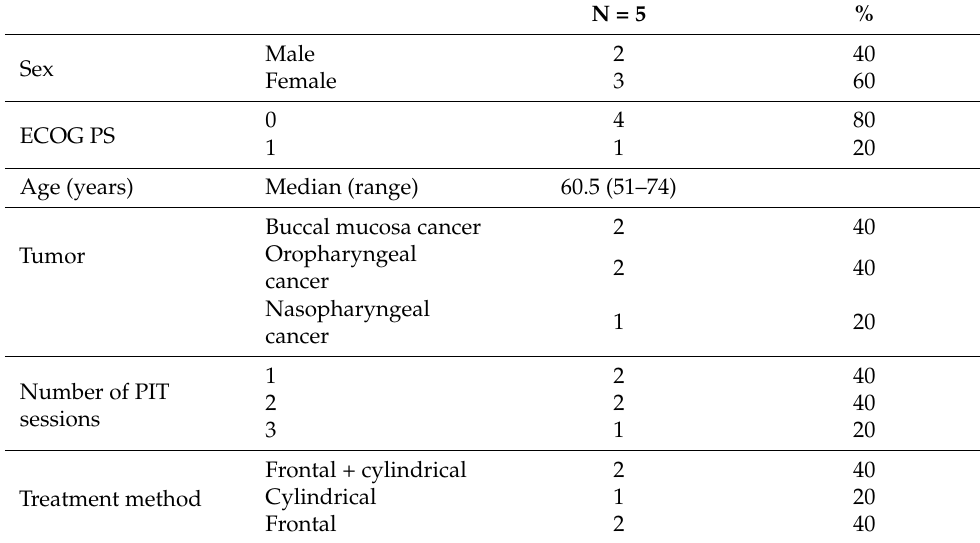
Table 1. Patient